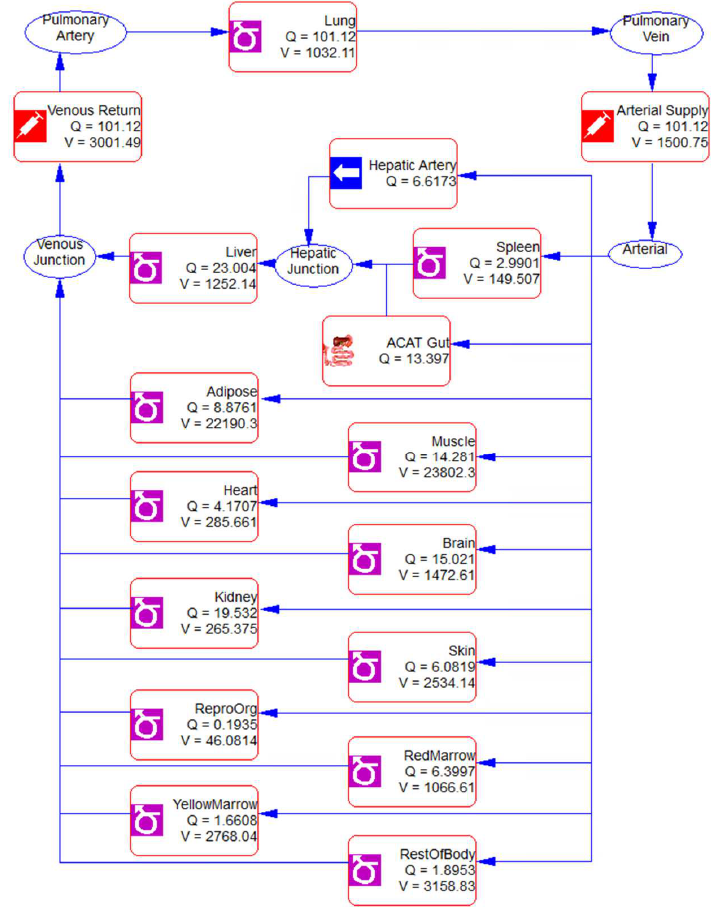
Figure 6. Model structure of the PBPK model of matrine using GastroPlus ® 9.8.